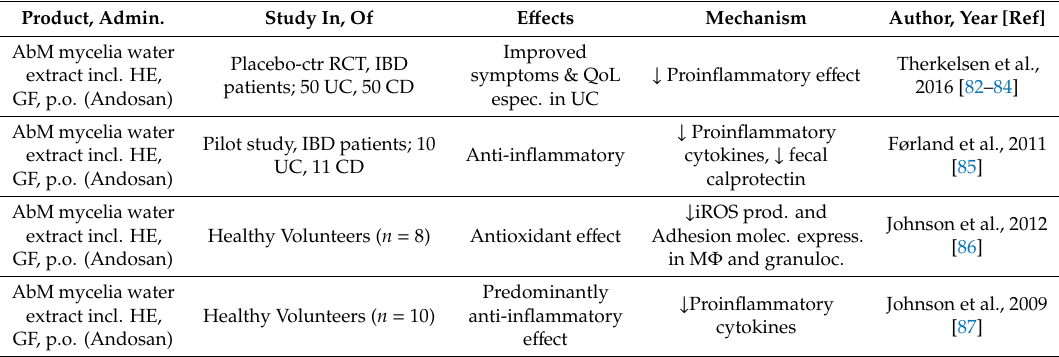
Table 5. Anti-inflammatory e ff ect of Agaricus blazei Murill—Clinical studies. Product,